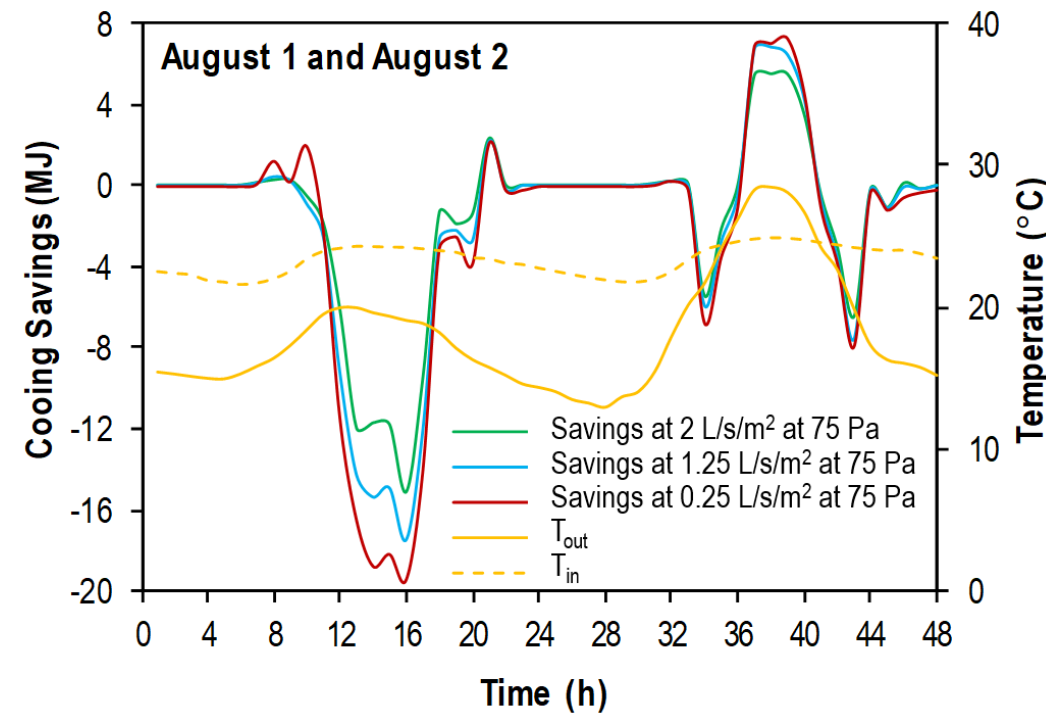
Figure 3. Hourly cooling energy savings at various airtightness levels for the stand-alone retail prototype building in San Francisco, California.